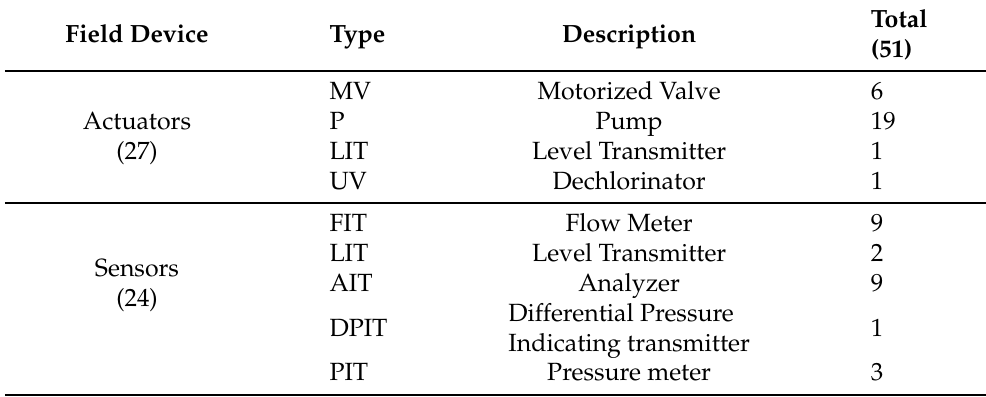
Table 3. Description of different sensors and actuators used for data generation. Features are named as combination of type (i.e., MV, P, FIT etc.) and suffix (process number and device number). For example, FIT-101 can be read as being a first flow meter sensor of process stage